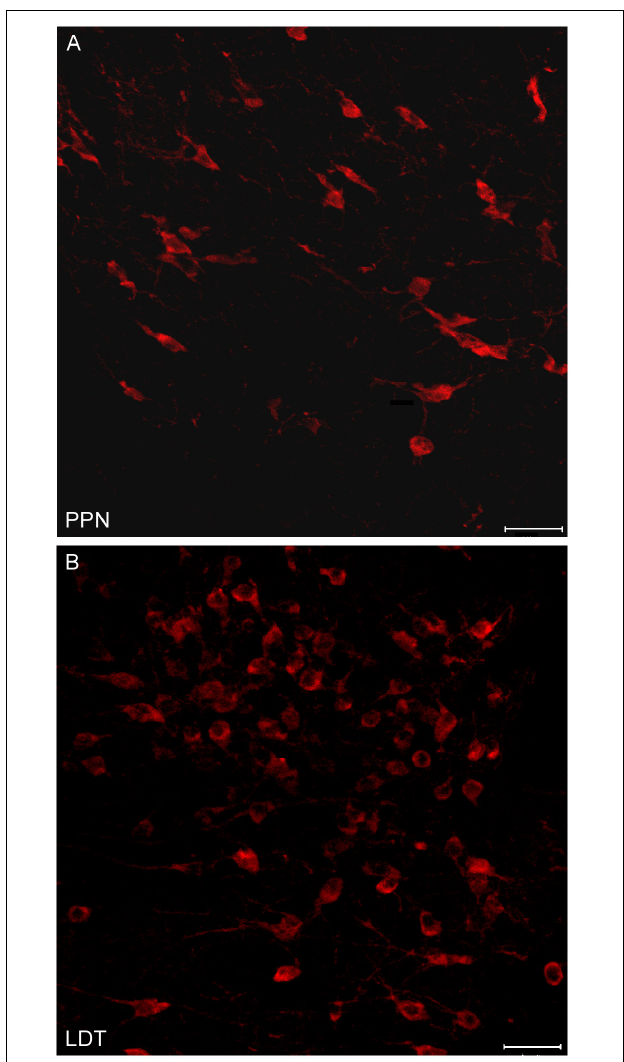
FIGURE 4 | Different neuronal density of cholinergic cells in the PPN and LDT. (A,B) Confocal z-stack images of ChAT-immunoreactive neurons from the (A) PPN and (B) LDT. Neurons in the PPN follow the orientation of the superior cerebellar peduncle fibers, and are generally less densely packed than cells in the LDT. Scale bar: 20 µ